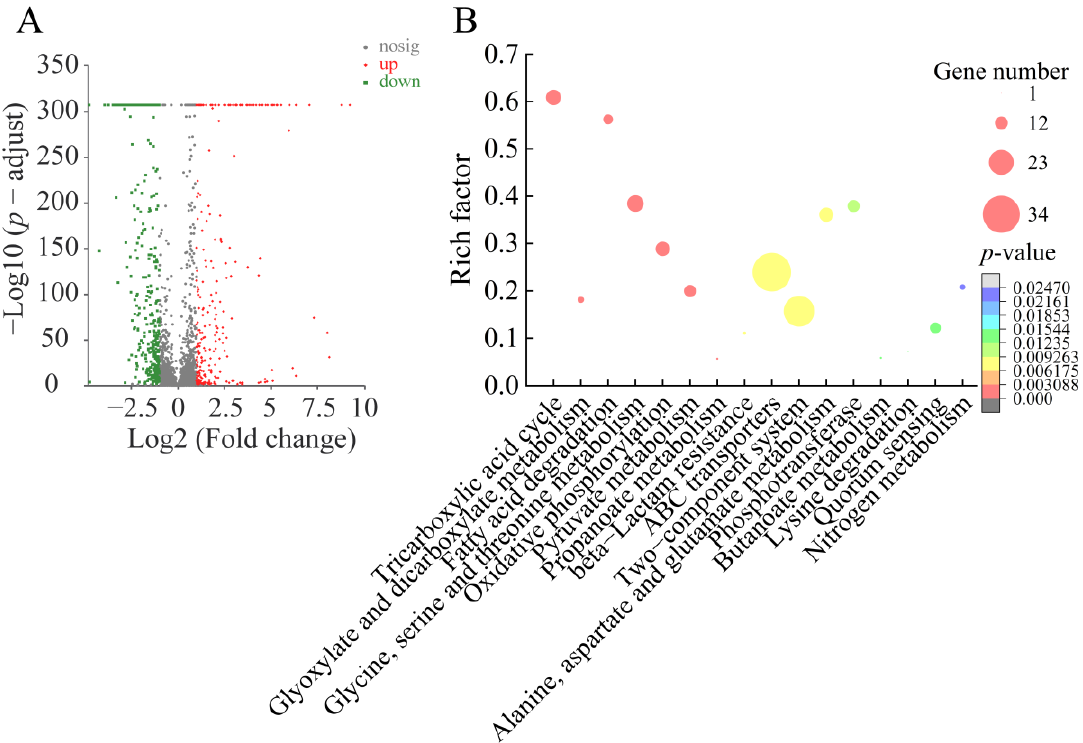
Figure 5. The major changed metabolic pathways in V. parahaemolyticus ATCC 17802 mediated by Fragment 1 from P. kleiniana Wight et Arn. (A) The Volcano plot of the DEGs. (B) The significantly altered metabolic pathways in the bacterium. Different colors represented significance levels of the enriched genes. Table 4. The major altered metabolic pathways in V. parahaemolyticus ATCC17802.